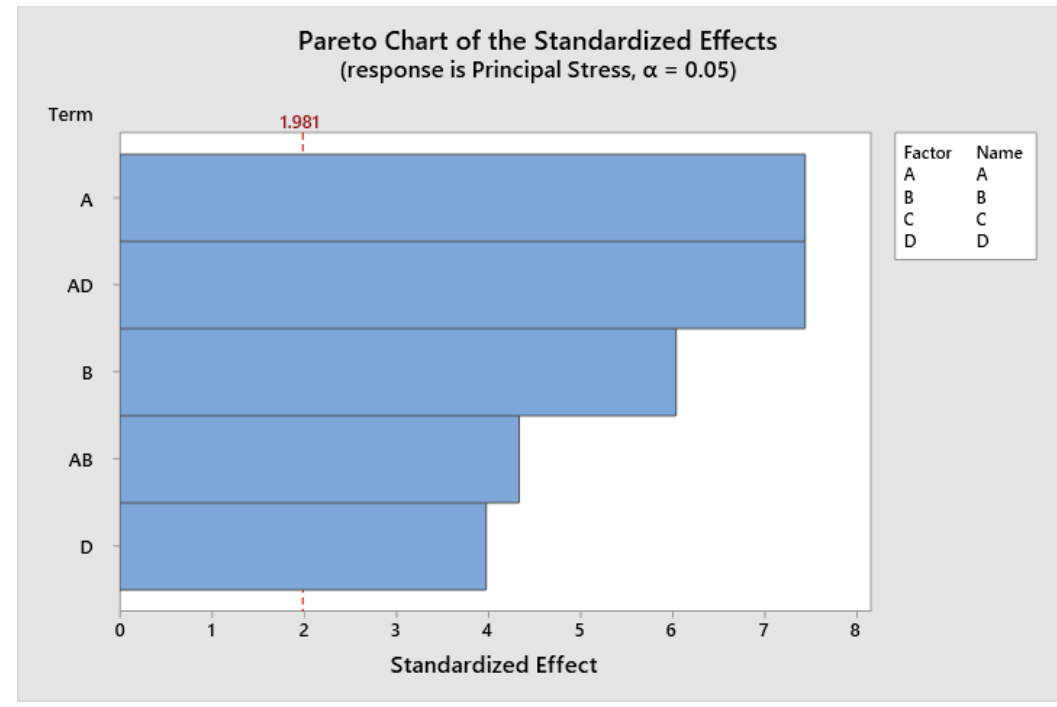
Figure 8. Pareto chart of the effects of principal stress (two locking screws).